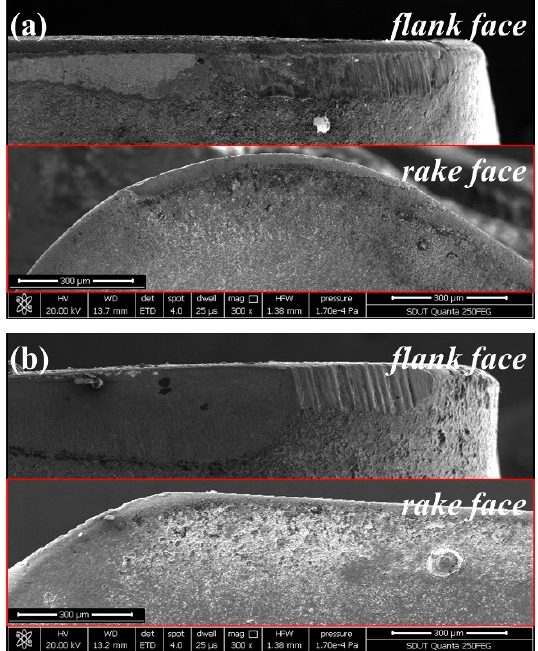
Figure 8. Rake wear and flank wear at v c = 280 m/min, f z = 0.02 mm, a p = 0.2 mm, and a e = 2 mm, ( a ) TiAlN + TiN coating, and ( b ) TiCN + NbC coating.